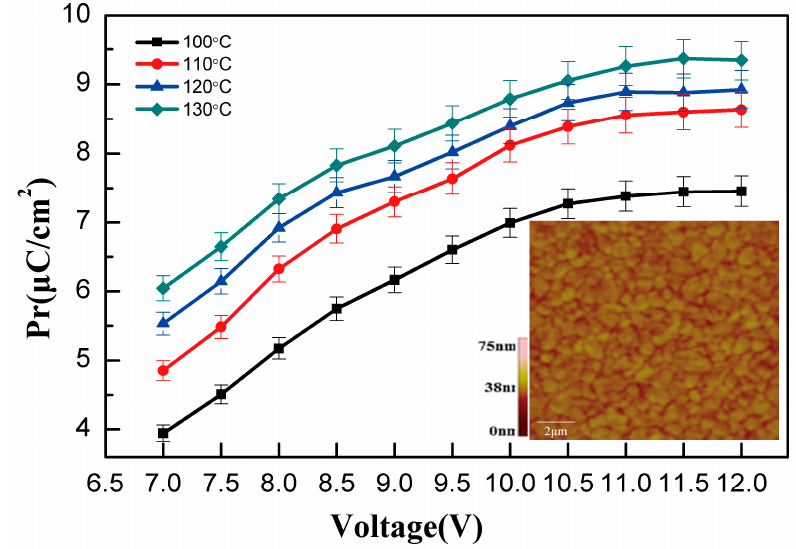
Figure 2. The P r as a function of driver voltage from 7 V to 12 V at different anneal temperatures (100–130 °C). The inset shows CA2 sample AFM (Atomic Force Microscopy) images of a 76-nm P(VDF-TrFE) film.